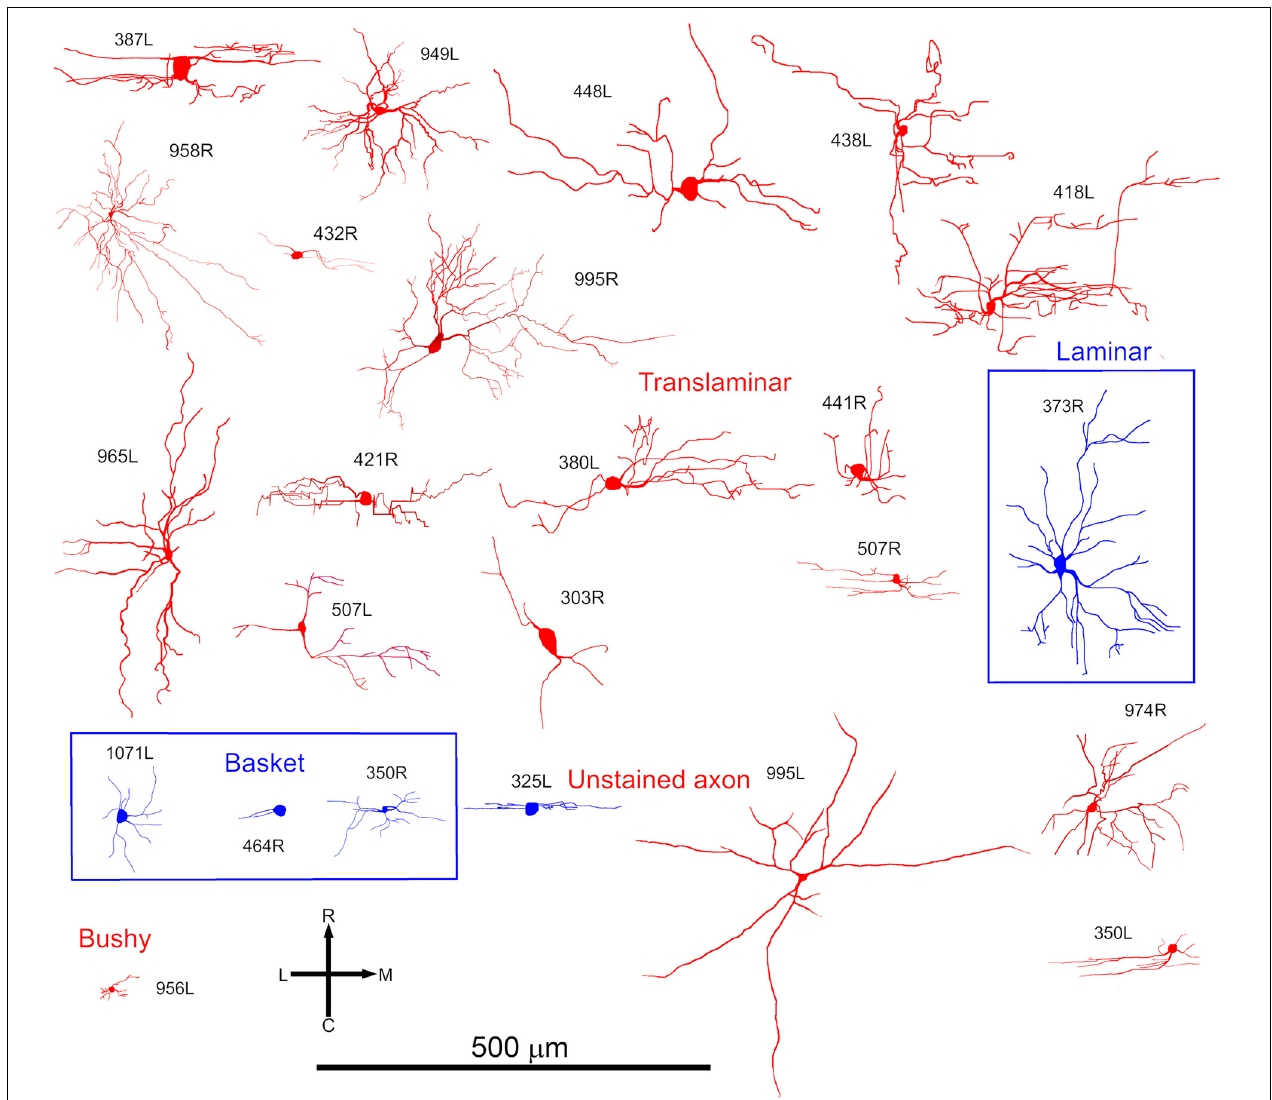
FIGURE 3 | Somata and dendrites of all the cells shown in the same order as in Figure 2 but viewed in the horizontal plane. At this orientation most cells have a stellate arrangement of their dendrites but some have an elongated pattern.